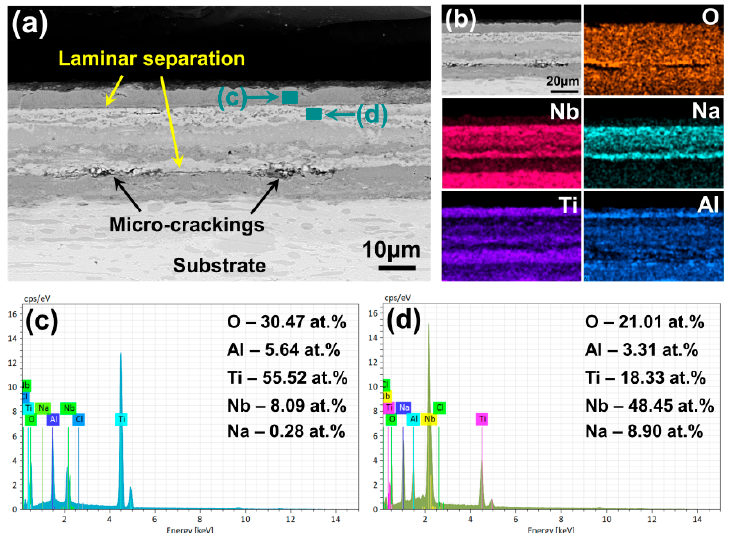
Figure 8. Cross-sectional SEM images and EDS spectra of the samples after alternating high temperature and salt spray test: ( a , b ) Microstructure of sample D3; ( c , d ) EDS analysis of sample D3.